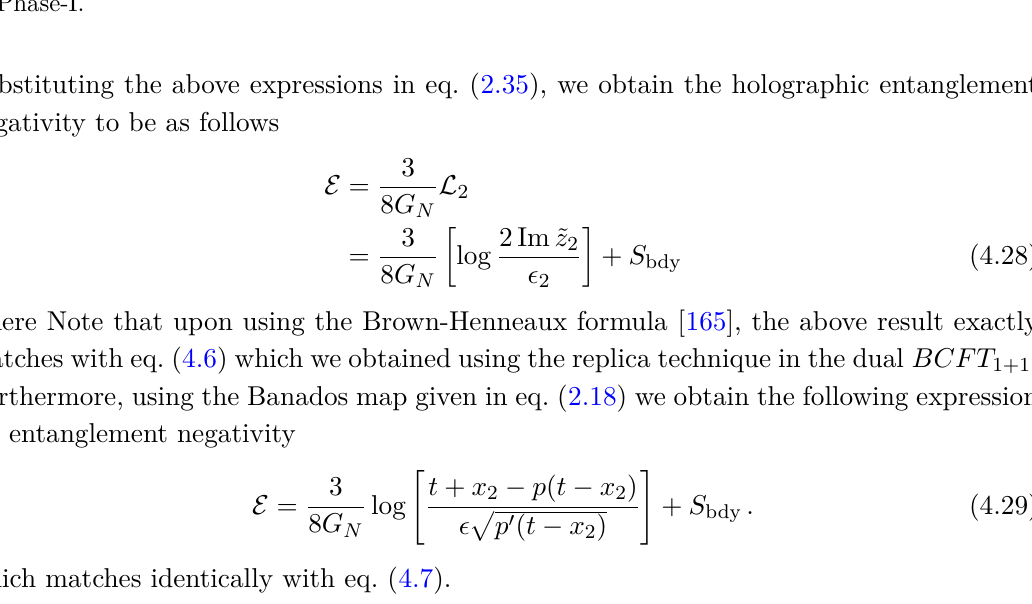
Figure 21. Geodesics contributing to the holographic entanglement negativity of adjacent intervals in